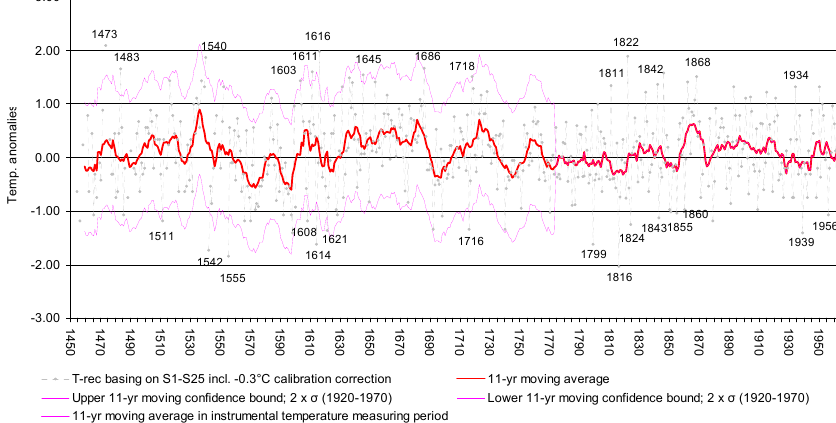
Fig. 8. Mean March-July temperature anomalies reconstruction basing on Basel WGHD series 1454–1970. Fig. 8. Mean March–July temperature anomalies reconstruction basing on Basel WGHD series